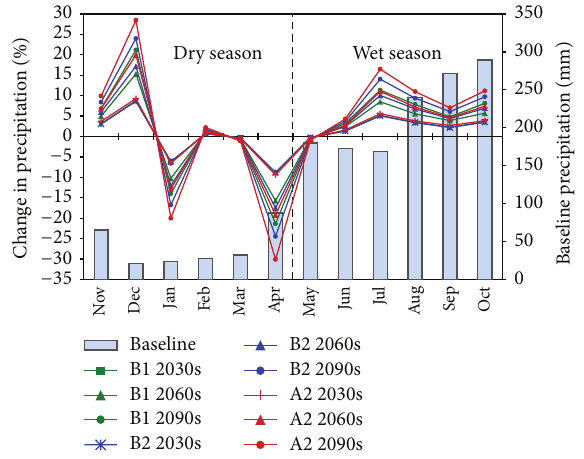
Figure7:Changeinmonthlymeanprecipitation(linechart)relative to average data of the baseline period (column